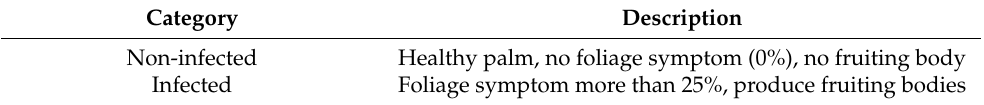
Table 1. Category and description of infection status of the oil palm trees.